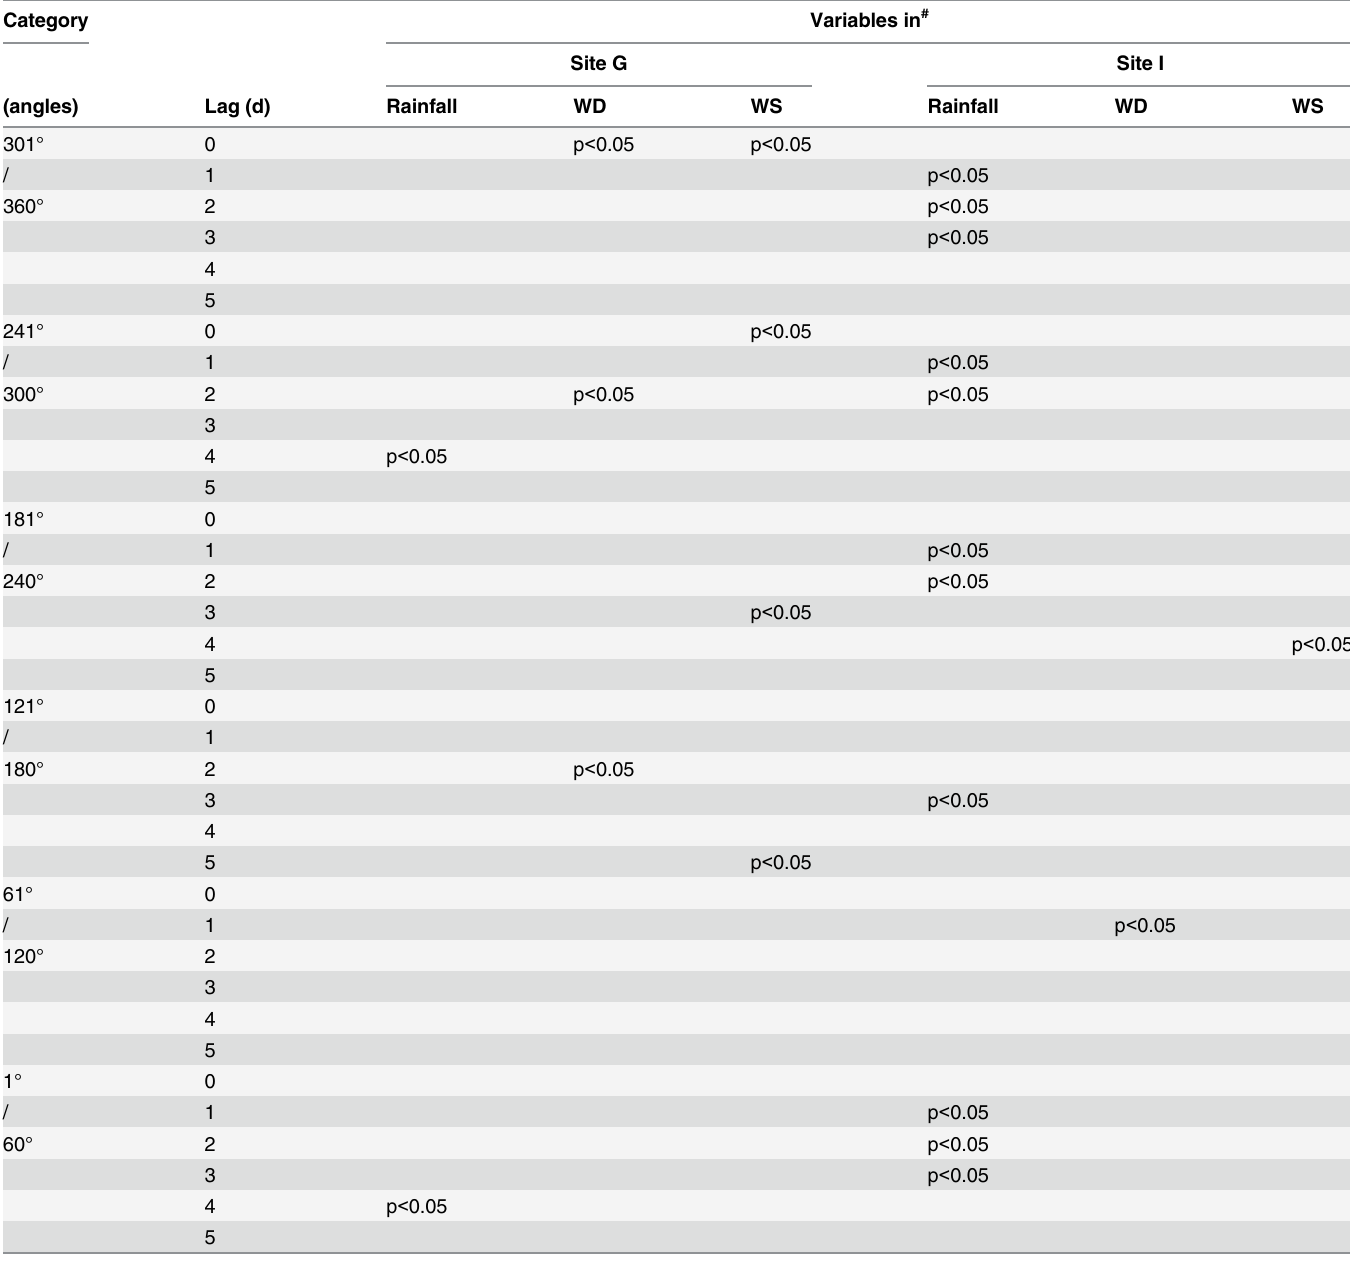
Table 2. Association between the B. pseudomallei -specific DNA concentration and multiple variables (rainfall, wind direction [WD] and wind speed [WS]) with time lag.